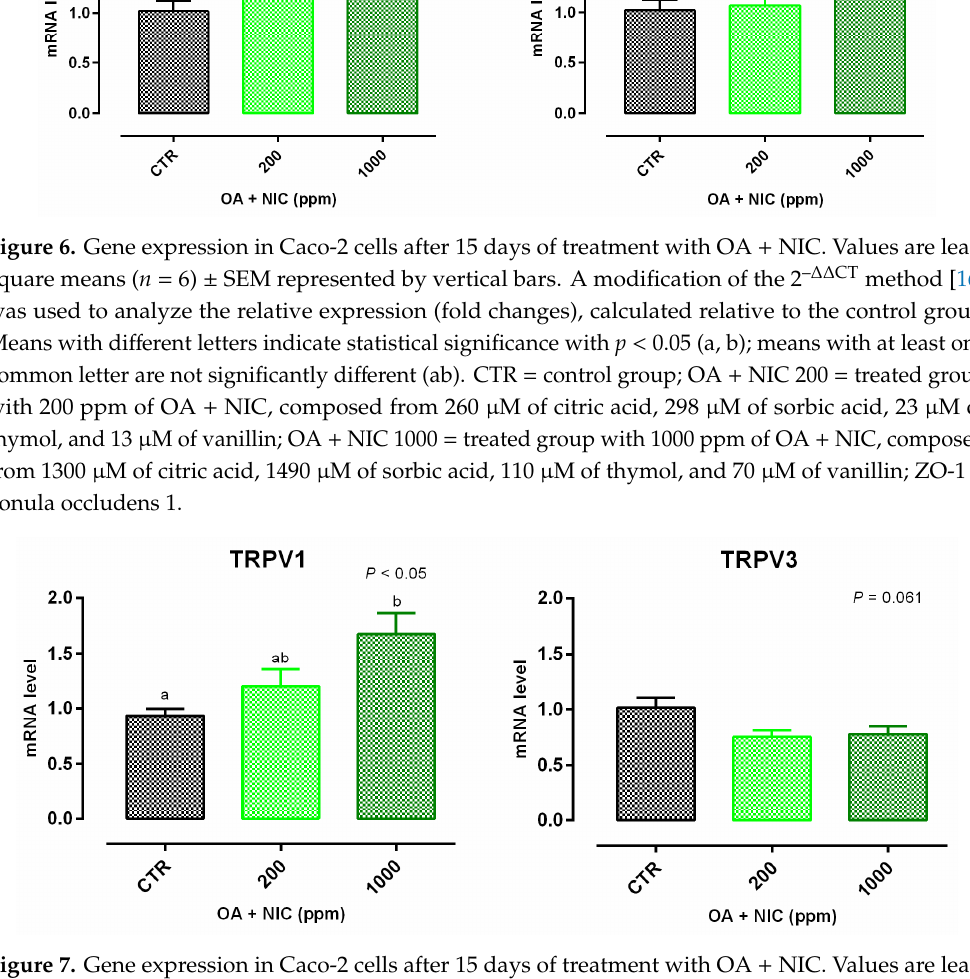
Figure 7. Gene expression in Caco-2 cells after 15 days of treatment with OA + NIC. Values are least square means ( n = 6) ± SEM represented by vertical bars. A modification of the 2 – ∆∆ CT method [16] was used to analyze the relative expression (fold changes), calculated relative to the control group. Means with di ff erent letters indicate statistical significance with p < 0.05 (a, b); means with at least one common letter are not significantly di ff erent (ab). CTR = control group; OA + NIC 200 = treated group with 200 ppm of OA + NIC, composed from 260 µ M of citric acid, 298 µ M of sorbic acid, 23 µ M of thymol, and 13 µ M of vanillin; OA + NIC 1000 = treated group with 1000 ppm of OA + NIC, composed from 1300 µ M of citric acid, 1490 µ M of sorbic acid, 110 µ M of thymol, and 70 µ M of vanillin; TRPV1 = Transient Receptor Potential Vanilloid 1; TRPV3 = Transient Receptor Potential Vanilloid 3.